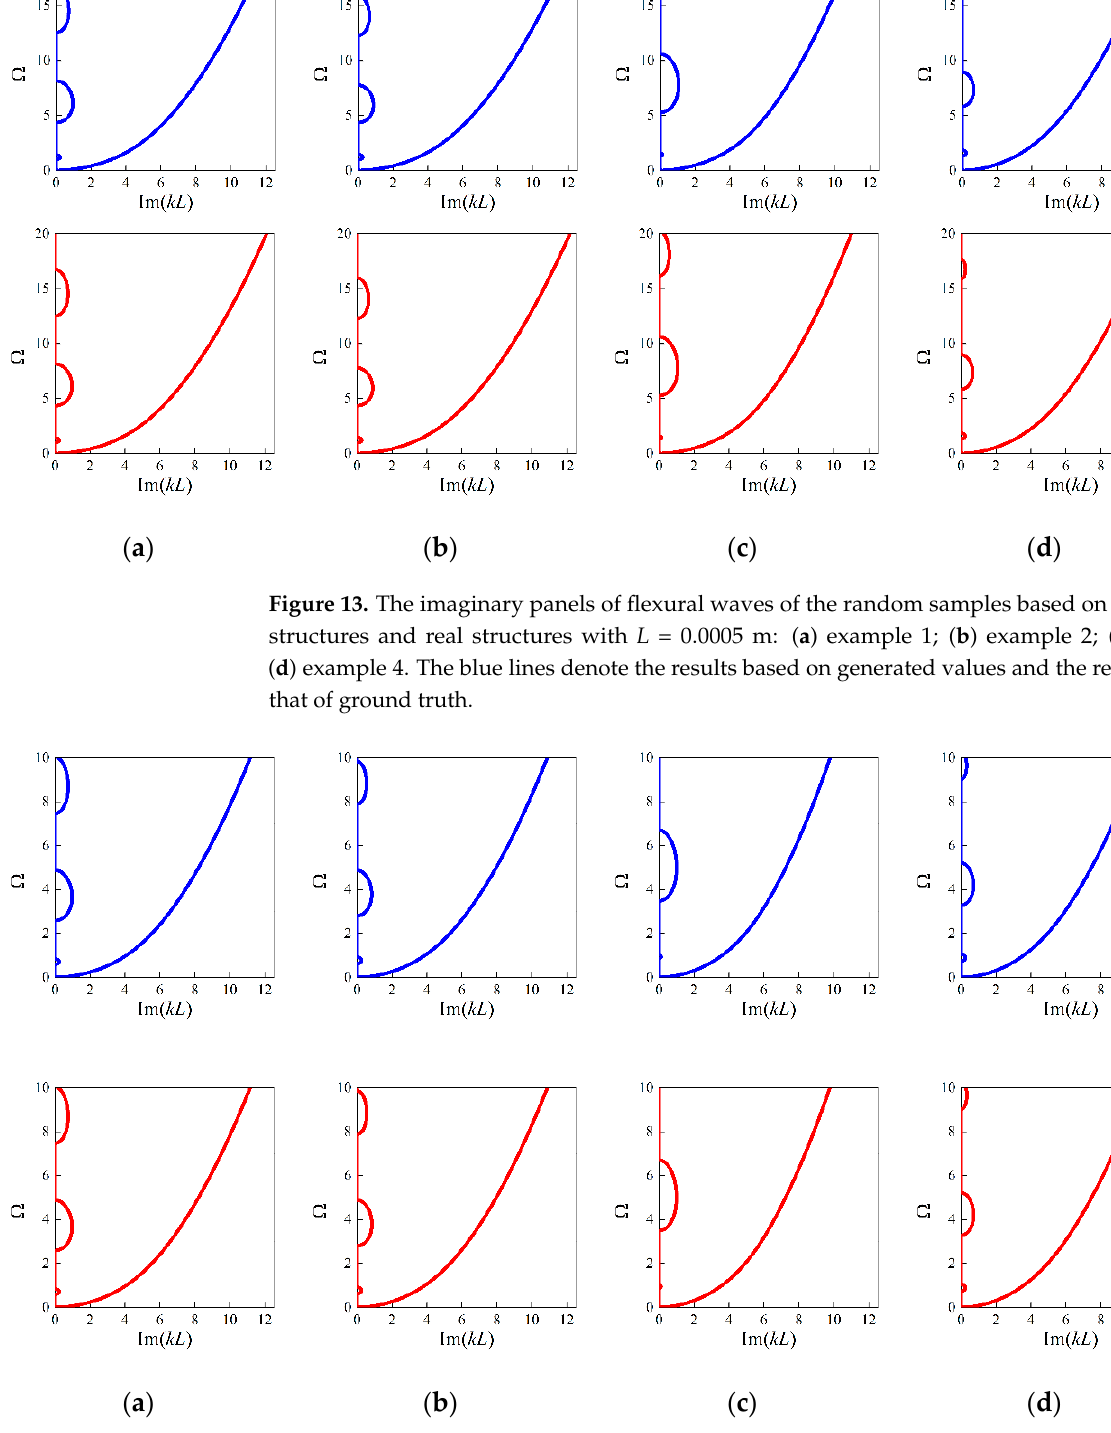
Figure 14 . The imaginary panels of flexural waves of the random samples based on the generated structures and real structures with L = 0.002 m: ( a ) example 1; ( b ) example 2; ( c ) example 3; ( d ) example 4. The blue lines denote the results based on generated values and the red lines denote that of ground truth.